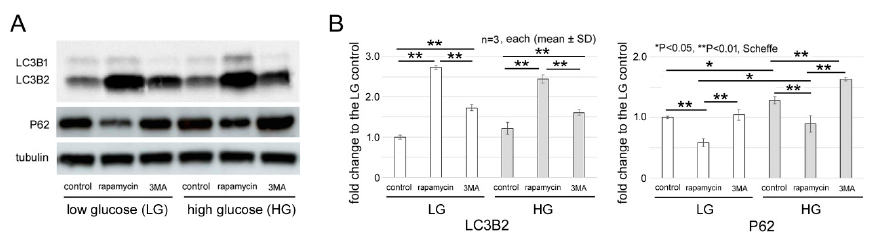
Figure 1. Western blots for LC3B2 and P62. ( A ) Representative protein bands of LC3B2 and P62 in extracts from 661 W cells cultured under different conditions. ( B ) Levels of LC3B2 and P62 are shown as fold changes (means ± SDs) relative to the low glucose (LG) control. Rapamycin increased the LC3B2 and decreased P62 levels significantly under both conditions indicating that autophagy was activated. P62 levels were higher under the high glucose (HG) control than those of the LG control, and addition of 3 methyl adenine (3MA), an inhibitor of autophagy, caused a further significant increase of P62 under HG conditions. (** p < 0.01, * p < 0.05, Scheffe; n = 3 each) .